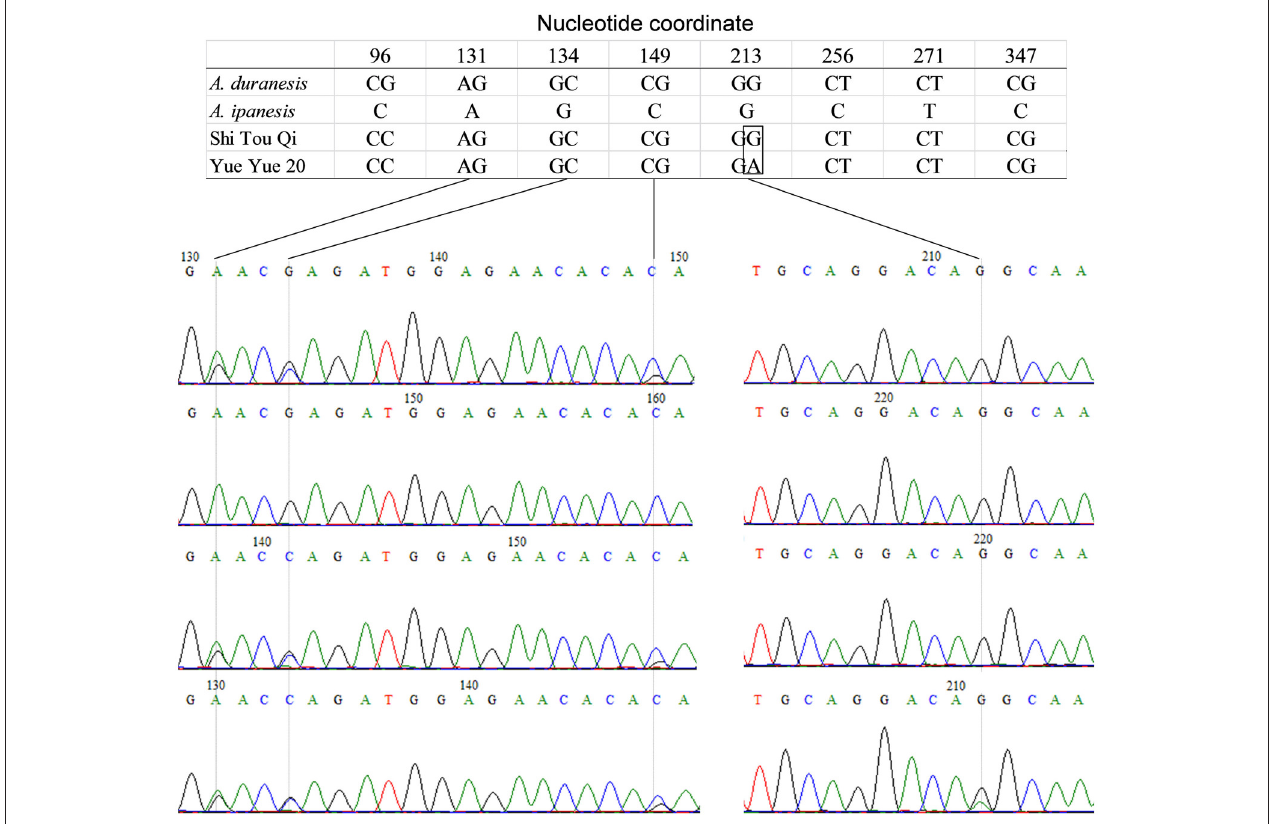
FIGURE 3 | Amplicon sequence of EST-87 in A. hypogaea and putative diploid progenitor. The figure shows that the A. duranensis genome contained two copies of sequence “EST-87” while A. ipaensis genome had only single copy. The single copy from A. duranensis genome was retained in A. hypogaea genome.